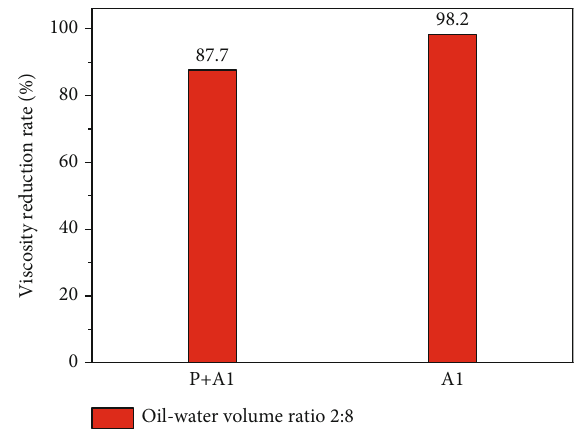
Figure 8: The viscosity reduction rate of surfactant A1 and polymer/surfactant A1